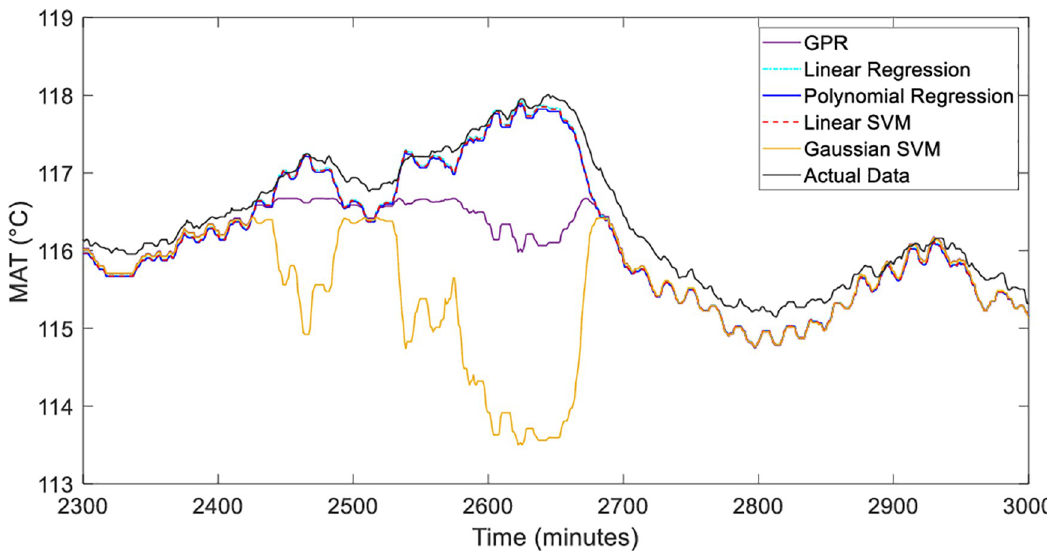
Fig 10. T h response in zoomed-in between 2300 and 3000